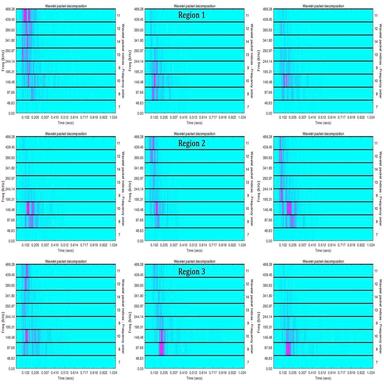
WPT analysis of AE hits in specimen B.